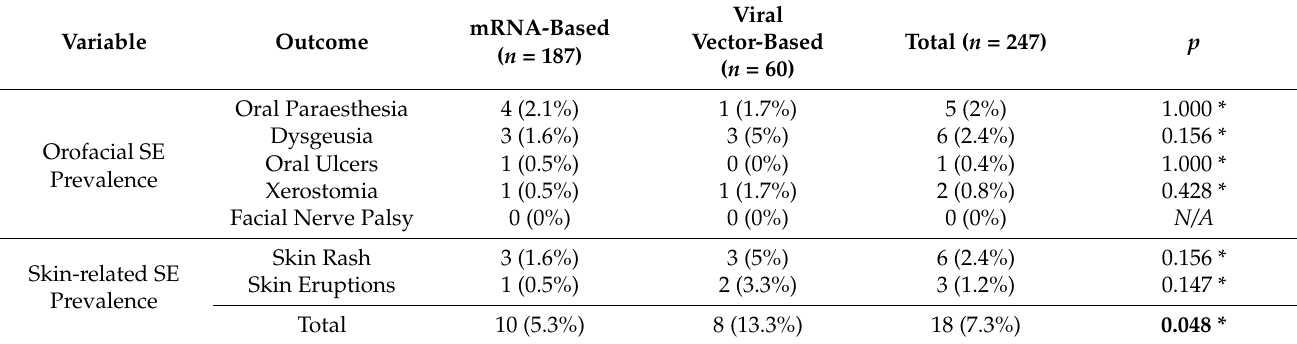
Table 6. Orofacial and skin-related adverse events of COVID-19 vaccines reported by Polish healthcare workers.